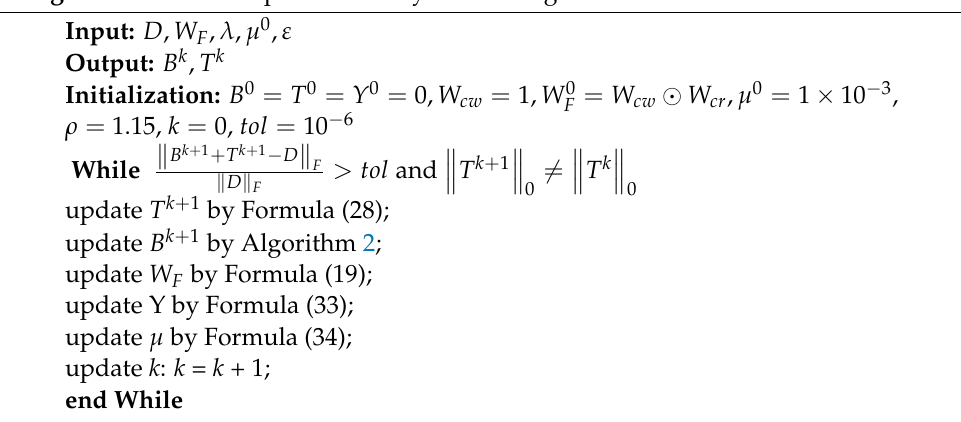
Algorithm 3: Model optimization by ADMM